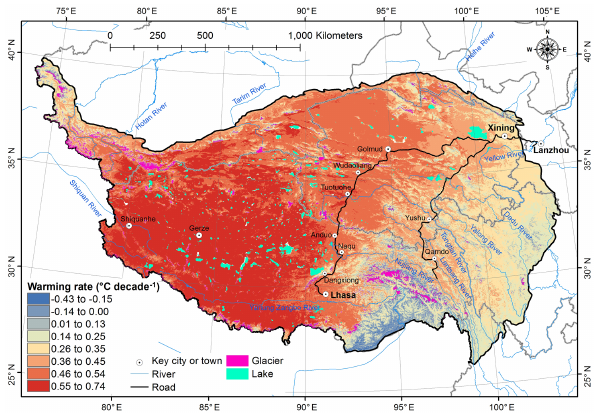
Figure 2. Spatial variability of MAAT warming rates over the QTP in the past 50 years.